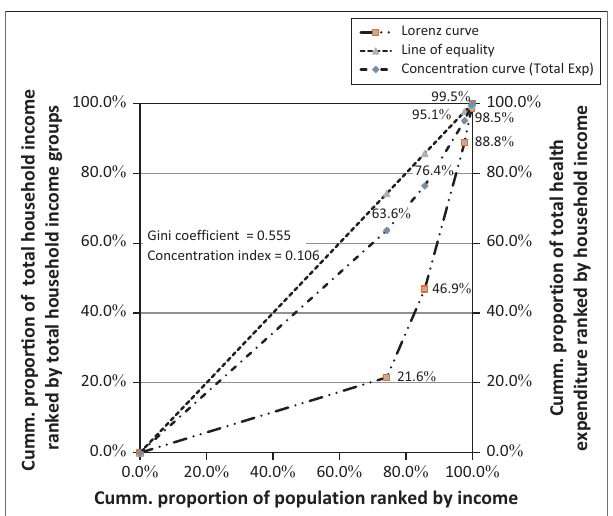
FIGURE 2: The Lorenz curve of income and the direct maternal healthcare expenditure concentration curve.